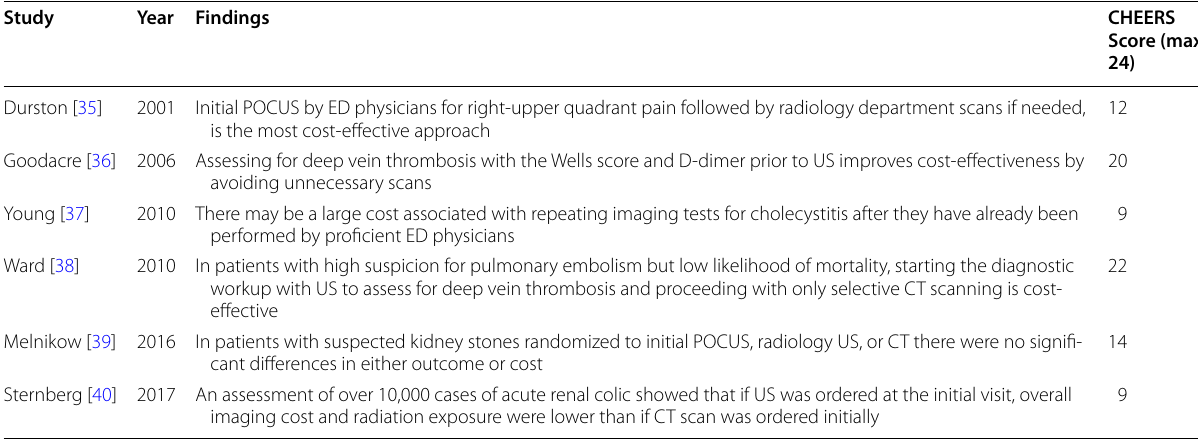
Table 3 Evaluation of renal, biliary, and venous pathology Study